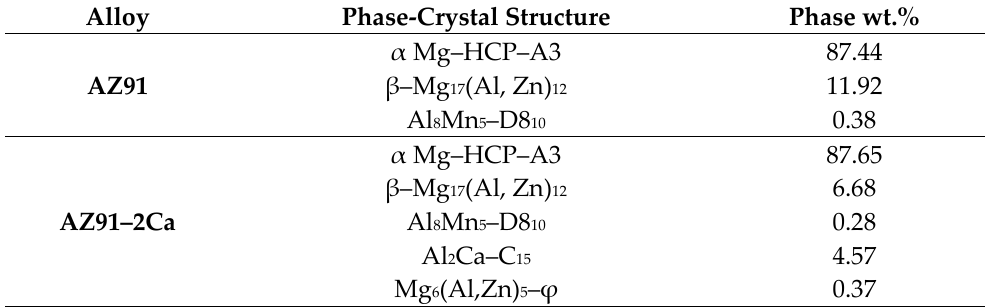
Table 2. Phase prediction in as-cast alloys at room temperature using FactSage-FTlite™ thermodynamic calculations. Calculated phases with a mass fraction below 0.1 wt% are not